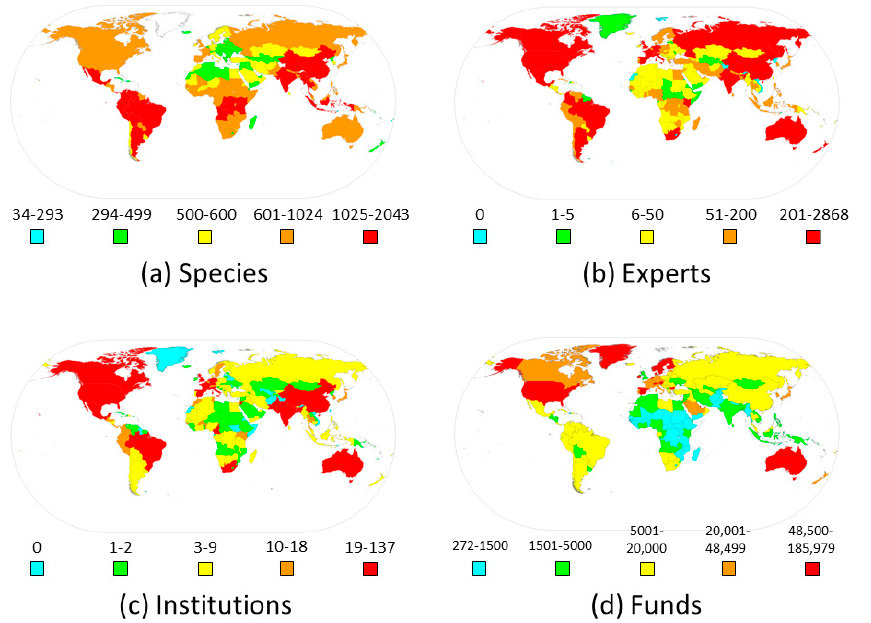
Figure 1. Global distribution of ( a ) species (bird richness per terrestrial territory), ( b ) experts (number of experts in the six volunteer IUCN Commission per country or territory), ( c ) institutions (num- ber of IUCN Members per country), and ( d ) funds ( per capita GDP by country in US$). Data for ( a ) were compiled from Avibase—The World Bird Database (https://avibase.bsc-eoc.org/avibase.jsp), ( b , c ) were provided by the IUCN Commission Support Unit, and ( d ) were compiled from World Bank national accounts data, and OECD National Accounts data files (https://data.worldbank.org/indicator/NY.GDP.PCAP.CD). Bird data for the US is for the conterminous 48 states [all data were accessed on 10 December 2021]. Table 1. Top 15 countries ranked from top to bottom according to the number of birds, experts, institutions and per capita GDP, as explained in Figure 1. In bold are the four countries in the second and third columns also present in the first one. There is no overlap between the first and fourth columns.